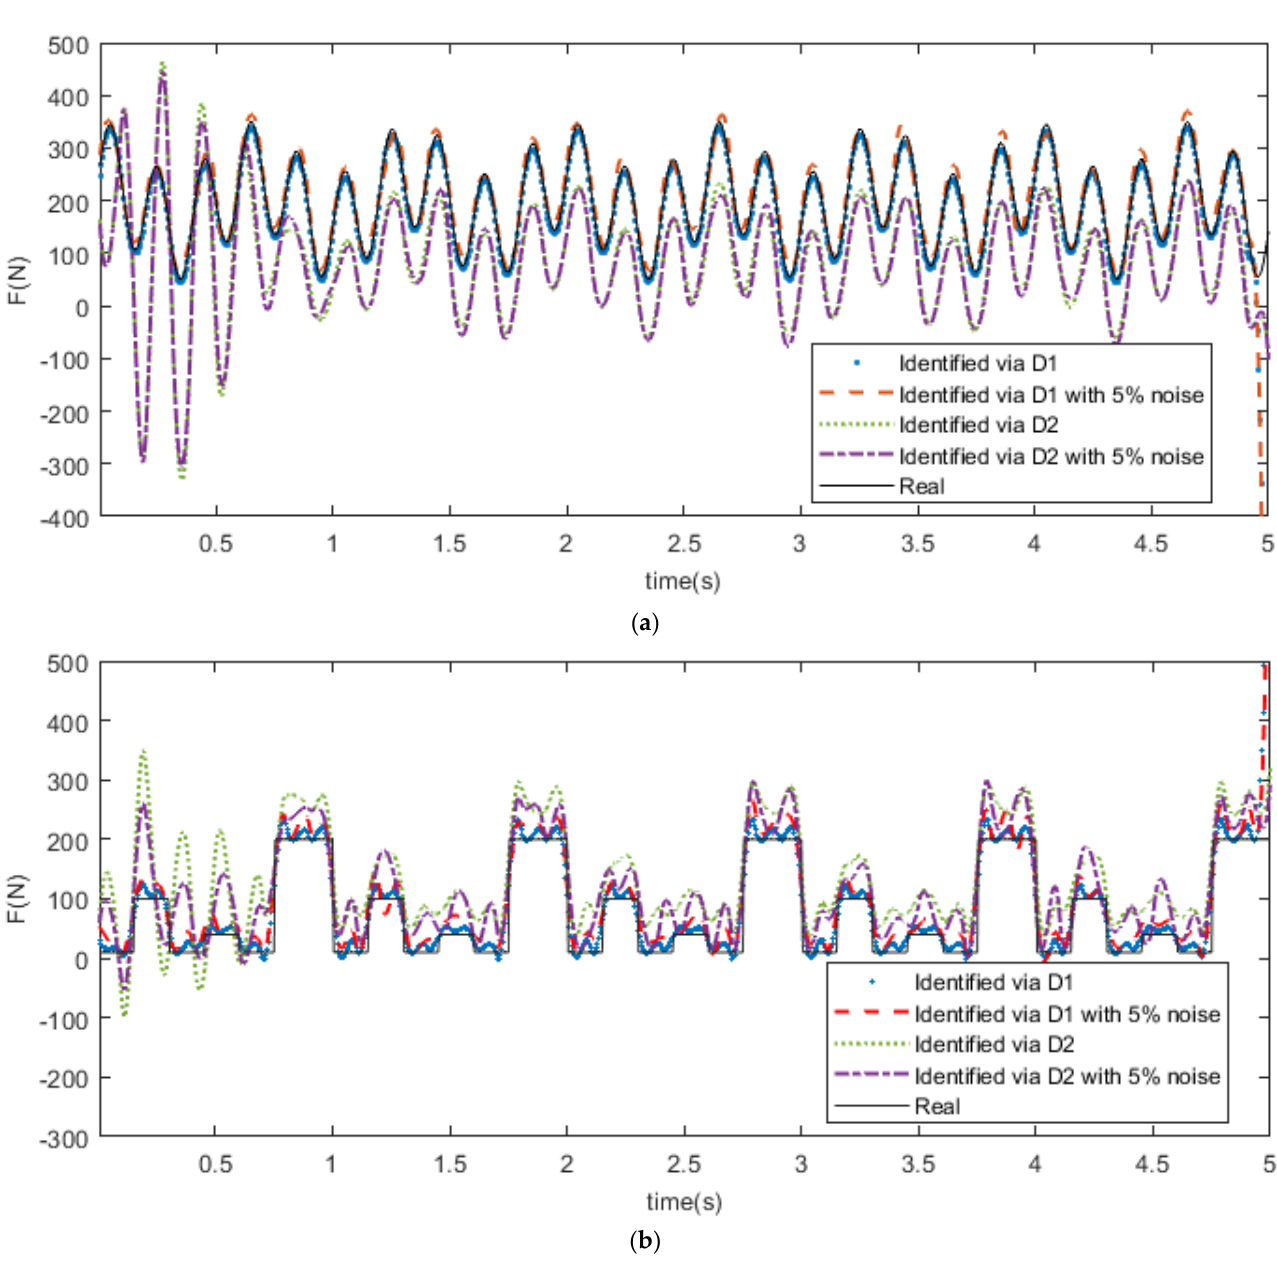
Figure 4. Fixed force identification results. ( a ) Harmonic force identification results; ( b ) Square wave force identification results. Table 1. RPE of fixed periodic load identification.